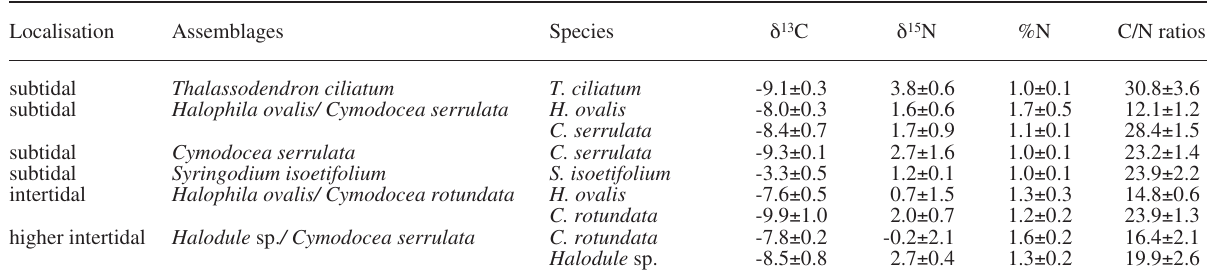
Table 2. – mean values (n=3) of δ 13 c (‰), δ 15 n (‰), nitrogen concentration (%